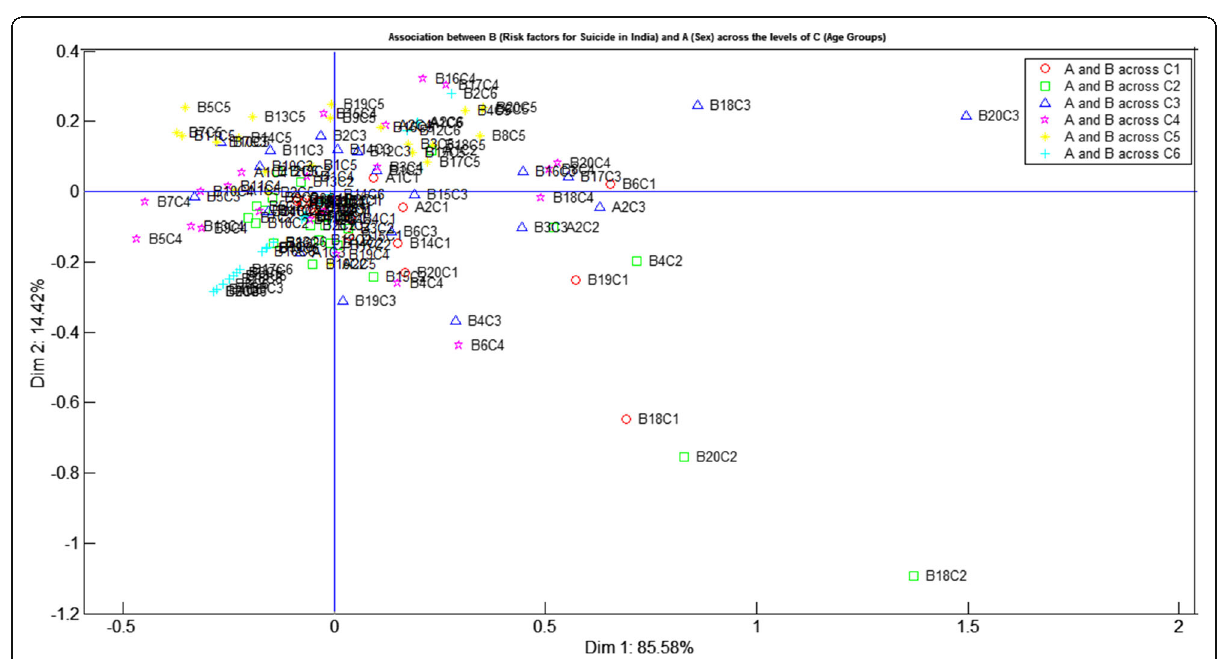
Fig. 9 Biplot showing association between B (Risk factors of Suicide) and A (Gender) across C (Age